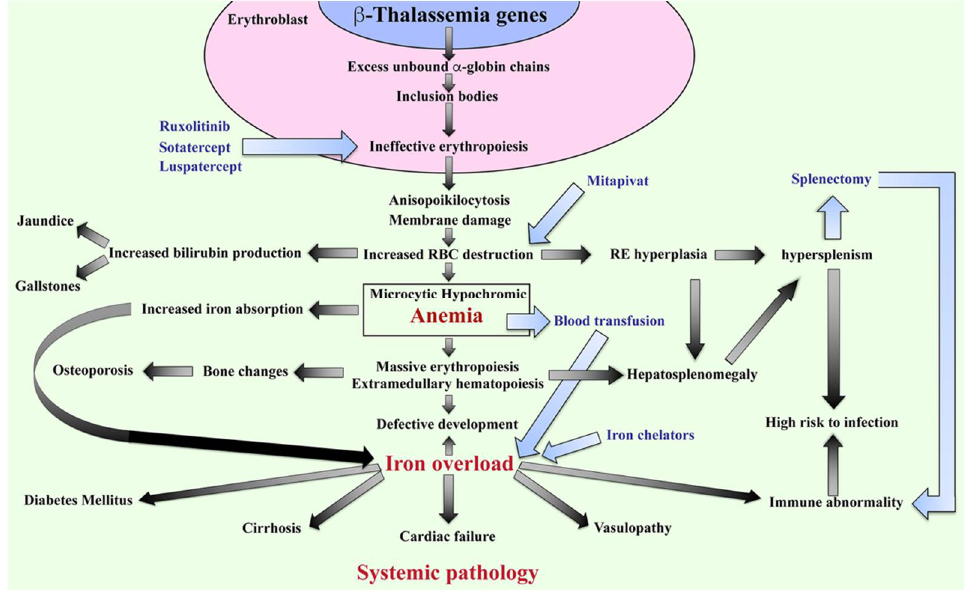
Figure 2. Pathophysiology of β-thalassemia. Defect in β -globin genes leads to reduced or absent β -globin production and consequent excess unbound α -globin chain accumulation and precipitation in erythroblasts, resulting in ineffective eythropoiesis. Abnormal RBCs, including anisopoikilocytosis, and RBCs with damaged membranes cause RBC destruction in the spleen leading to anemia, reticuloendothelial (RE) hyperplasia, and increased bilirubin production. Iron overload is a key factor in inducing a systemic pathology leading to increased mortality and morbidity in β -thalassemia patients. Blood transfusion and iron chelators are the conventional treatments for β -thalassemia. Curently, therapeutic drugs such as ruxolitinib, sotatercept, luspatercept, and mitapivat that target ineffective erythropoiesis by increasing Hb production are in clinical trials. Hb; hemoglobin, RBCs; red blood cells, and RE system; reticuloendothelial system.